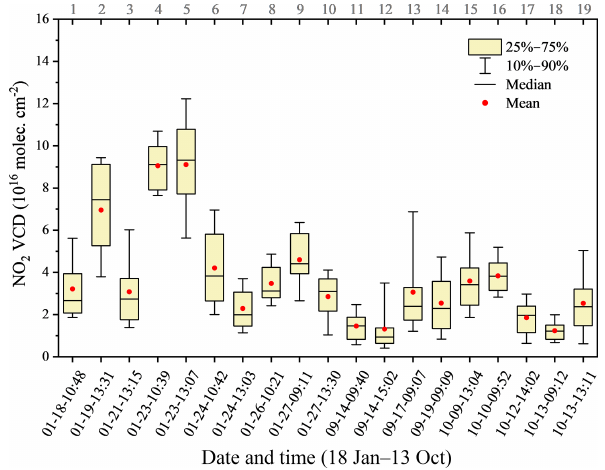
Figure 4. Time series of the tropospheric NO 2 vertical column den- sity (VCD) for 19 circling journeys on the 6th Ring Rd of Beijing in January, September, and October 2014. Lower (upper) error bars and yellow boxes are the 10th (90th) and 25th (75th) percentiles of the data of each journey, respectively. Hyphens inside the boxes are the medians, and red circles are the mean values. The numbers of each journey are labeled on the top axis. See Table 1 for detailed information about each